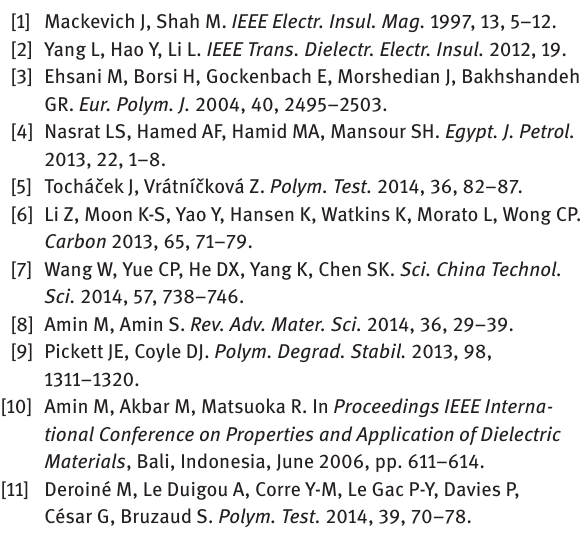
peaks of methyl groups on the surface do not reduce with